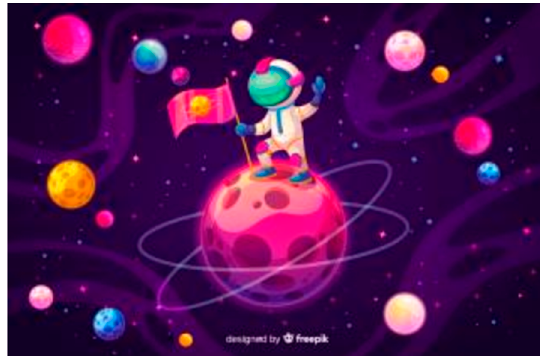
Figure 12. Image target.